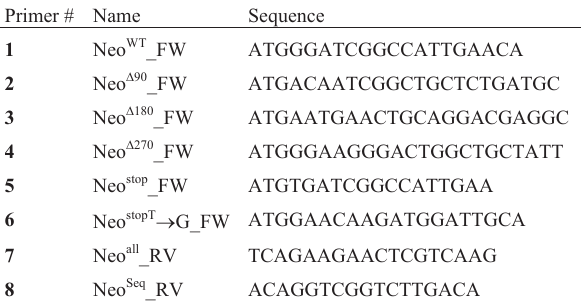
Table 1 - Primers used for reporter